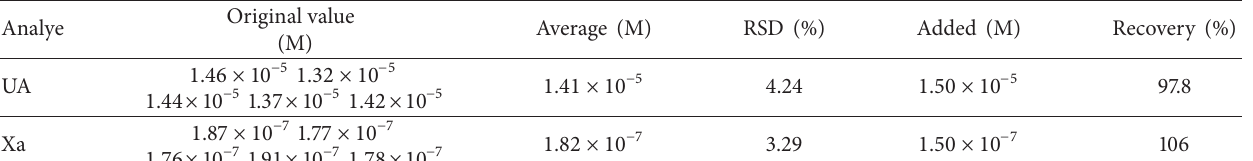
Table 6: Simultaneous determination of UA and Xa in human urine samples ( 𝑛 = 5 ).